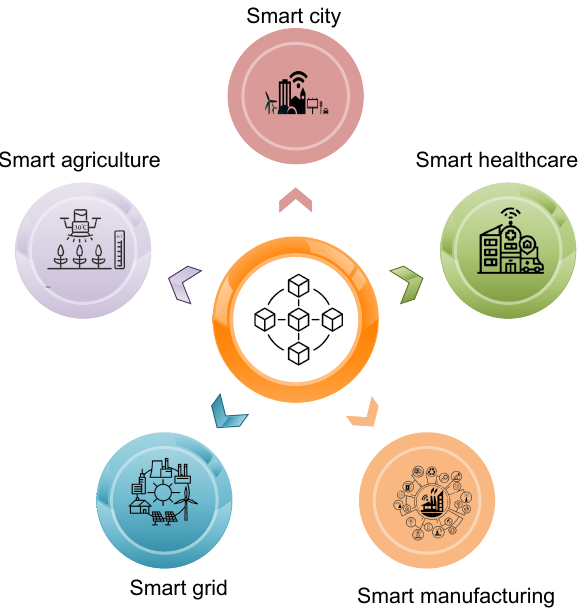
Figure 1. Applications of blockchain in 6G